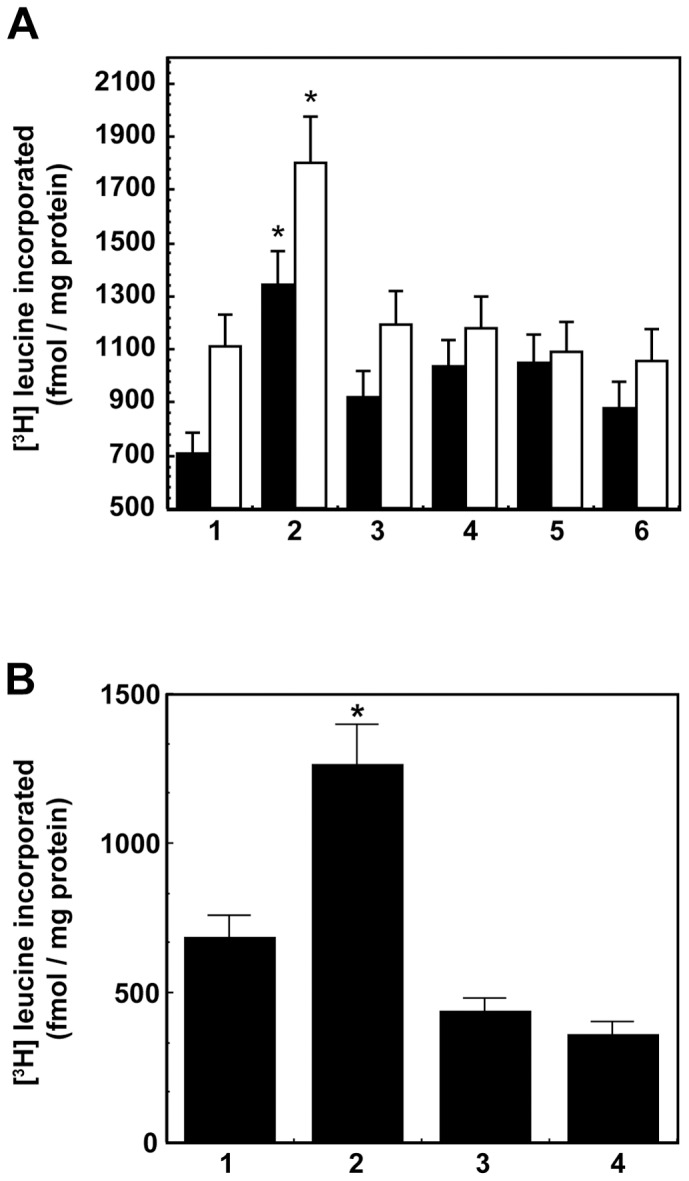
Suppression of 8-CPT-2Me-cAMP-induced protein synthesis in prostate cancer cells.
Panel A. The bars in the diagram are: (1) buffer; (2) 8-CPT-2Me-cAMP (100 μM/16 h); (3) AH23848 (1 μM/3 h); (4) AH-23848 then 8-CPT-2Me-cAMP; (5) SC-58125 (1 μM/3 h) and (6) SC 58125 then 8-CPT-2Me-cAMP. The black bars in Panel A and B are data for 1-LN cells and the white bars in Panel A are data for DU-145 cells. Panel B. The bars in the diagram are: (1) buffer and 8-CPT-2Me-cAMP (100 μM/16 h); (3) Torin1 and (4) Torin1 then 8-CPT-2Me-cAMP. Protein synthesis as determined by quantifying the incorporation of [3H] leucine into cellular proteins is expressed as fmol [3H] leucine incorporated mg protein and is the mean ± SE from three separate experiments in each panel. Values significantly different for buffer versus inhibitor-treated cells (Figure 2A) and buffer versus Torin-treated cells (Figure 2B) at the 5% level are marked with an asterisk (*).